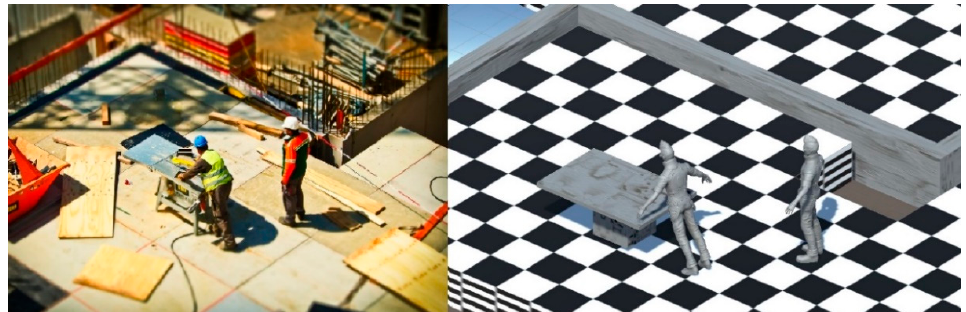
Figure 1. Reflecting the physical elements in the digital twins (DT) environment.